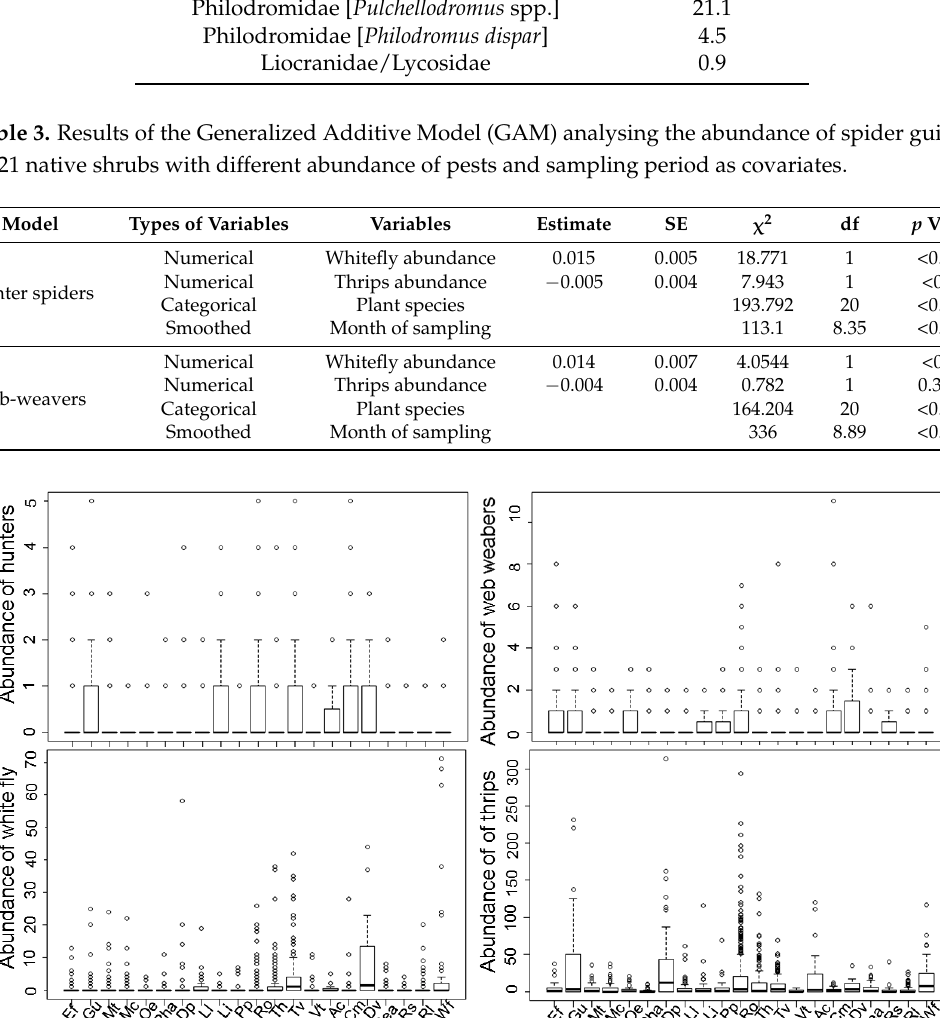
Figure 1. Abundance of hunter spiders, web-weaver spiders and the pests Bemisia tabaci and Frankliniella occidentalis in the different plant species using the plant codes from Table 1.